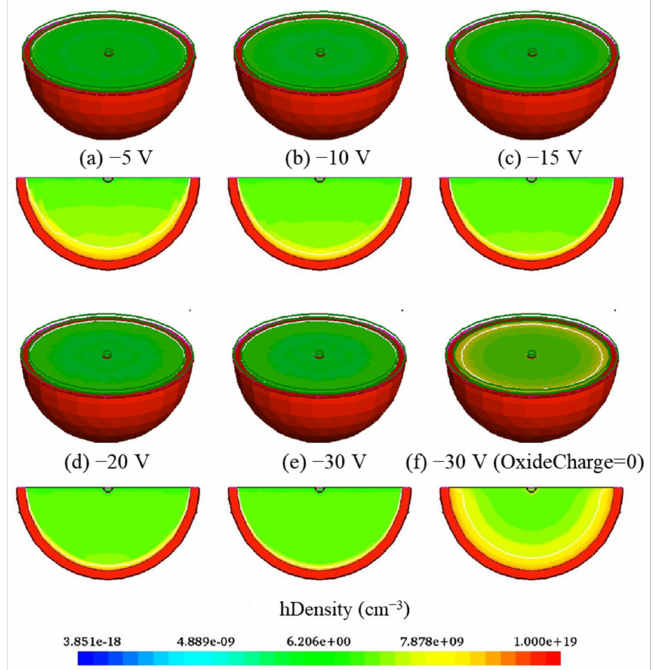
Figure 4. 3D and 2D hole concentration distributions with different bias